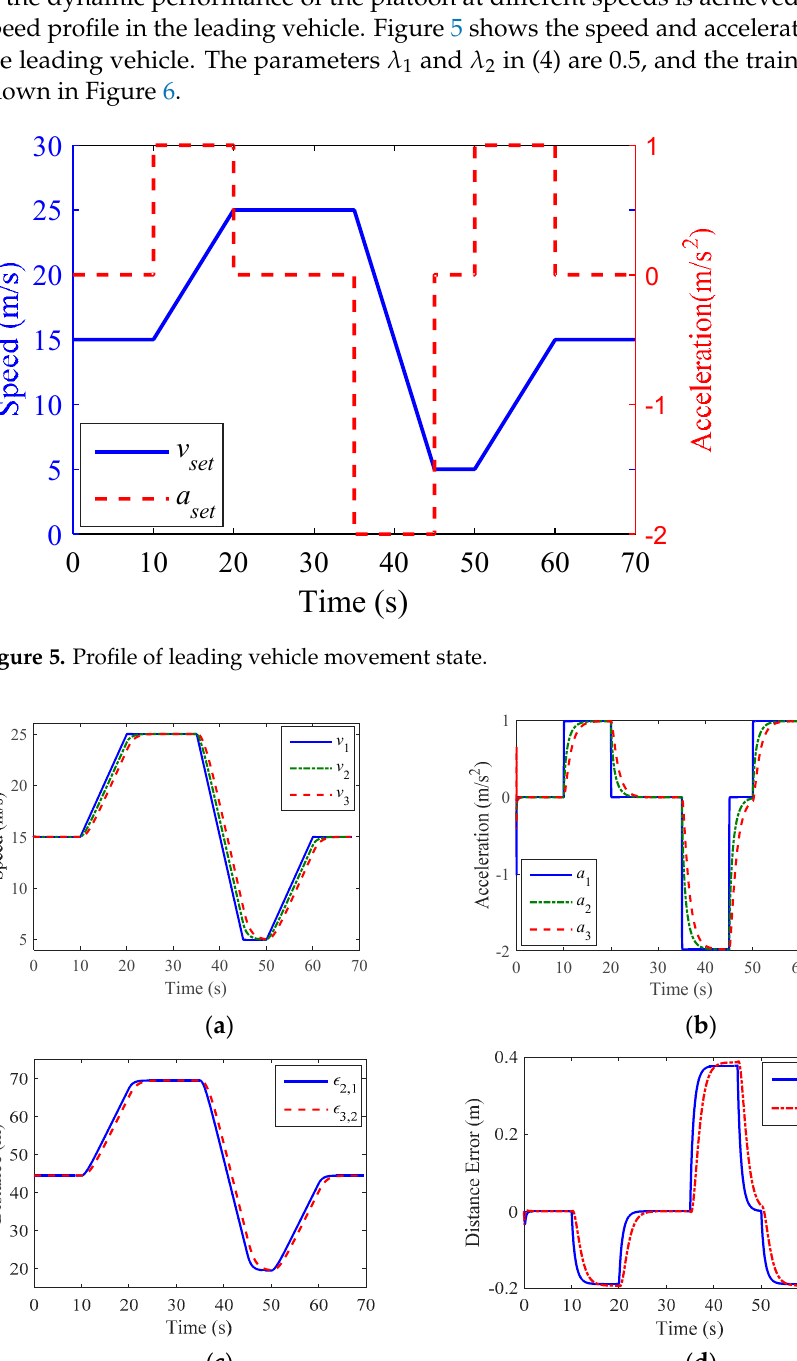
( d ) Figure 6. Vehicle platoon tracking performance in training conditions. ( a ) Vehicle speed v i (t) ( i = 1, 2, 3). ( b ) Vehicle acceleration a i ( t ) ( i = 1, 2, 3). ( c ) Inter-vehicle distance between consecutive vehicles ε i,i − 1 ( t ) ( i = 2, 3). ( d ) The distance error with the desired distance e i,i − 1 ( t ) ( i = 2, 3).